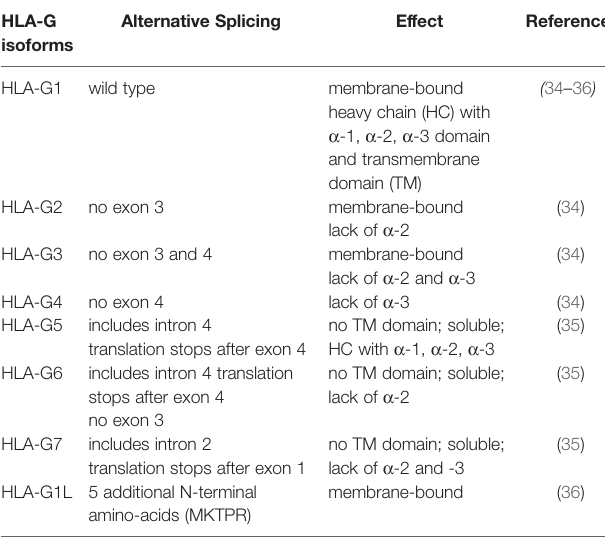
TABLE 1 | Overview of all described HLA-G